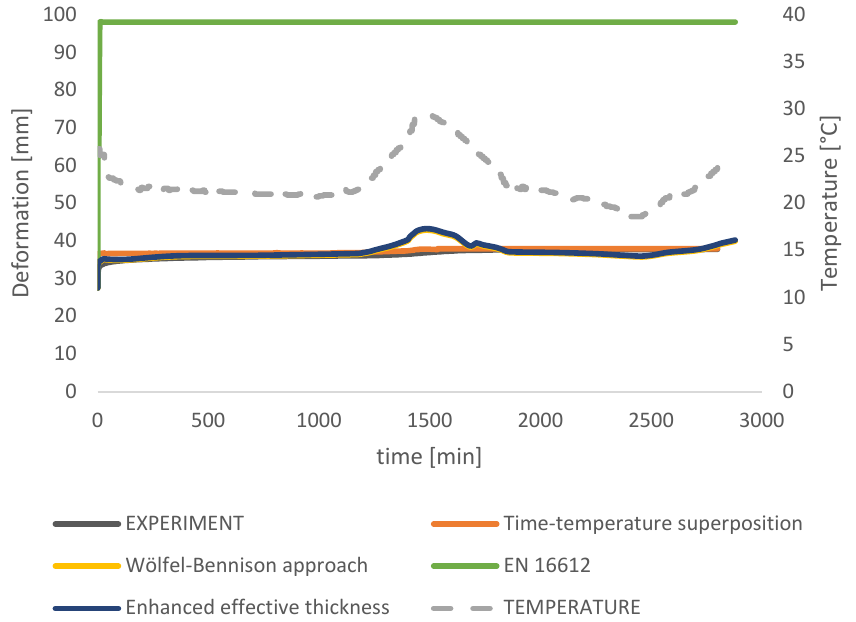
Figure 13. Deformation comparison of different glass design analytical approaches with measured data: EN 16612; Wölfel-Bennison approach; Enhanced effective thickness approach; Effective thick- ness approach combined with TTS correction of Shear Modulus G.